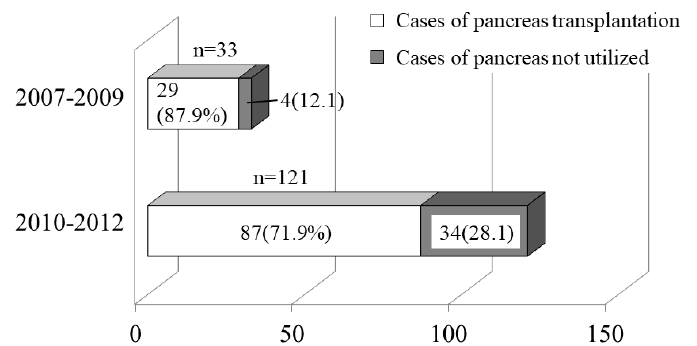
Figure 3. Use of pancreases procured from brain-dead donors (BDDs) for organ transplantation before and after the revision of the law. The percentage of pancreases procured from BDDs for organ transplantation was compared between 2007–2009 and 2010–2012. The percentage of pancreases procured from BDDs decreased from 87.9% before the revision to 71.9% after the revision.